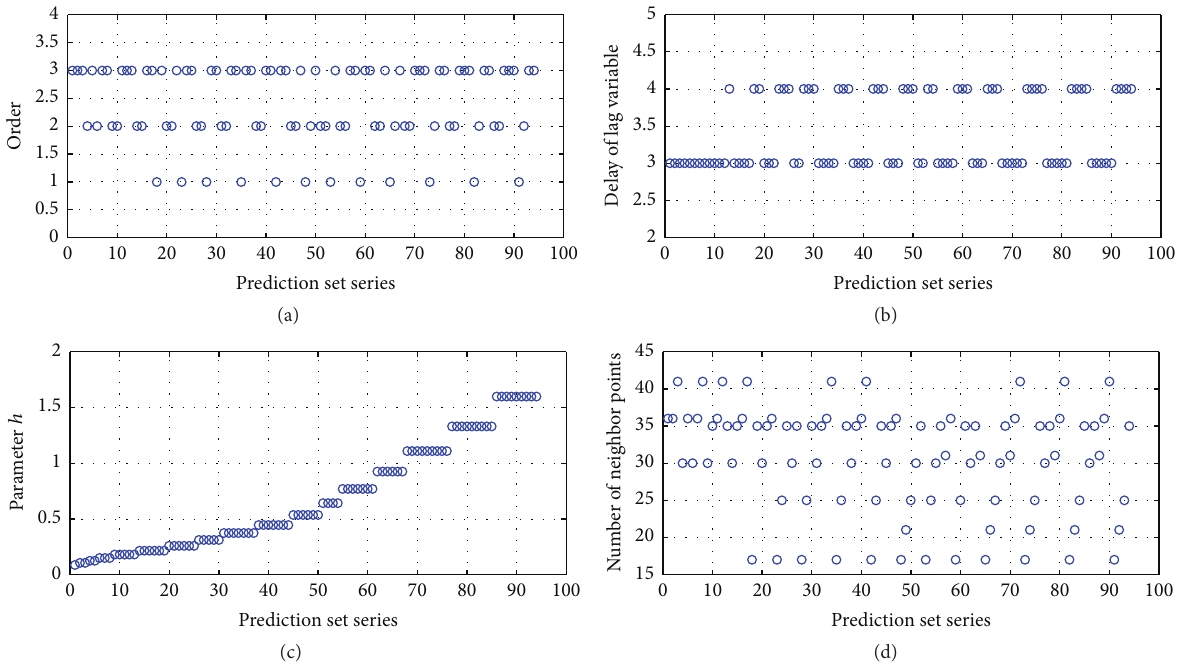
Figure 8: Results of Mackey-Glass time series’ multistep prediction: (a) the order of functional coefficients; (b) the delay of the lag variable; (c) the weight parameter; (d) the number of nearest neighbor points.